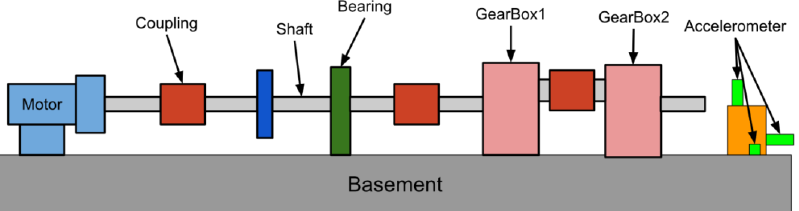
Figure 7. Schematic diagram of composite fault vibration data